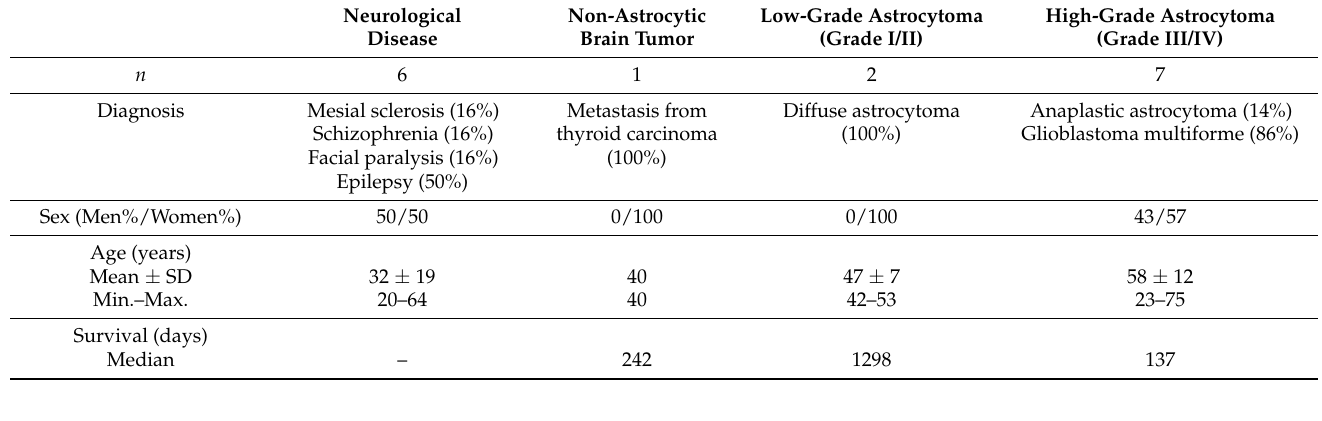
Table 3. Clinical and demographic features of patients.